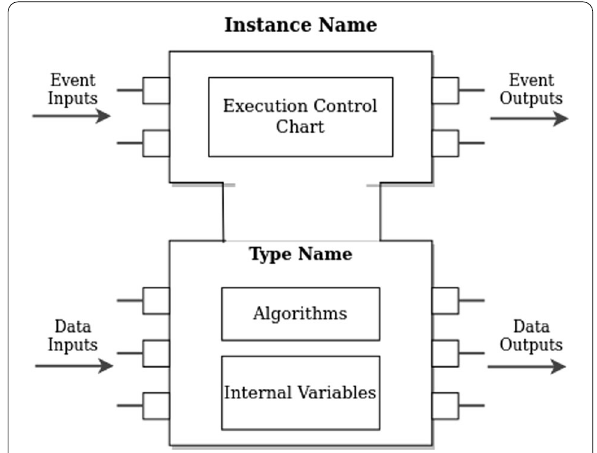
Fig. 1 Generic interface of an IEC 61499 function